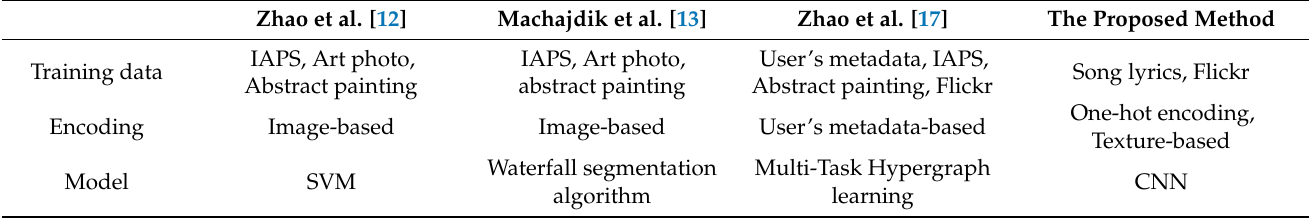
Table 1. Comparison of the proposed method and image synthesis methods. Zhao et al. [12] Machajdik et al. [13] Zhao et al. [17] The Proposed Method